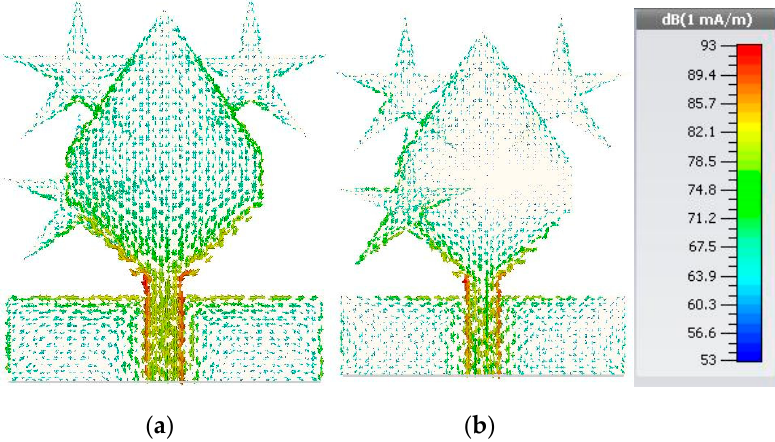
Figure 5. ( a ) Reflection coefficient (S 11 ). ( b ) Peak gain and efficiency (measured).